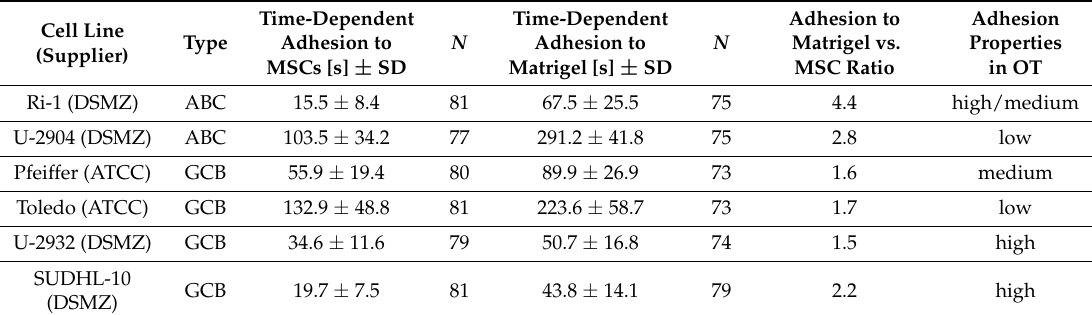
Table 1. Table showing the average contact time required for the formation of adhesion between diffuse large B-cell lymphoma (DLBCL) cells and mesenchymal stromal cells (MSCs)/Matrigel in optical tweezers in normoxia. ATCC-American Type Culture Collection, DSMZ-German Collection of Microorganisms and Cell Cultures, N-number of cells measured in tree independent experiments, OT-optical tweezers, SD-standard